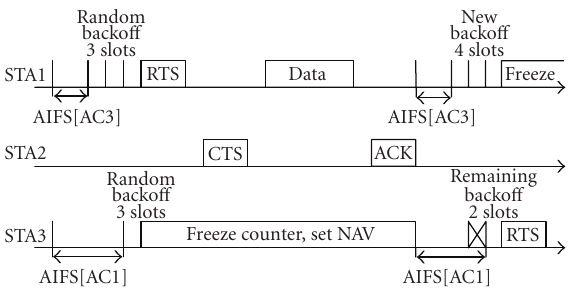
Figure 2: IEEE 802.11e EDCA channel access procedure.